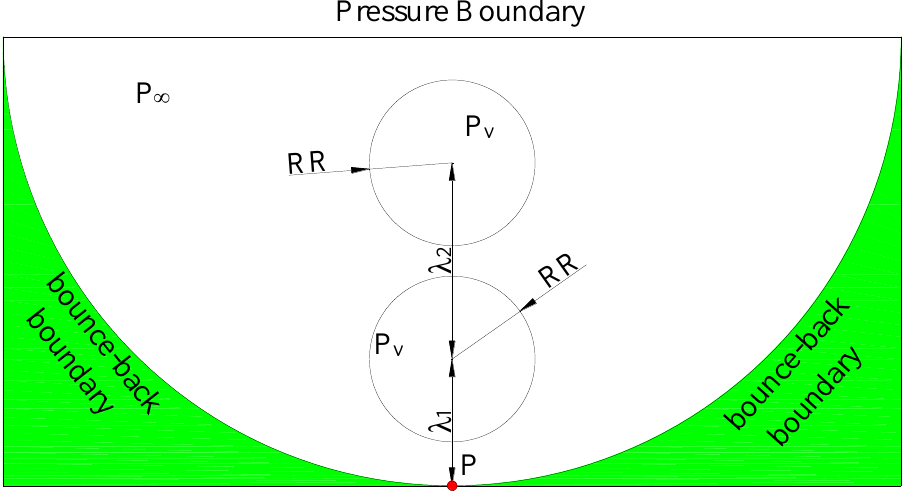
Figure 12. Computational layout for double bubbles with vertical arrangement. ( λ 1 is the distance between the center of lower bubble and the point P and λ 2 is the distance between the centers of two bubbles). Table 3. Used parameters in Cases 7–9.